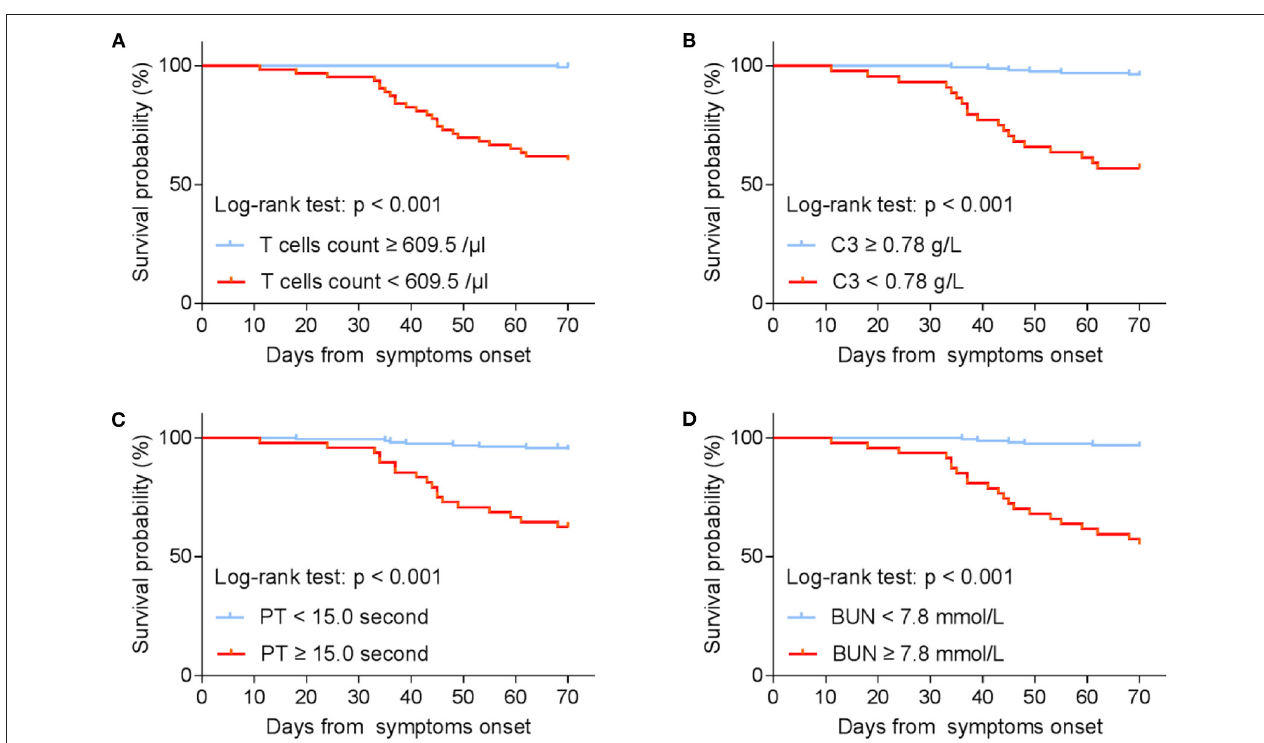
FIGURE 2 | Kaplan–Meier estimates on survival by (A) T cells count; (B) C3; (C) PT; (D) BUN (stratified according to best cut-off). T cell, T lymphocyte; C3, complement component 3; PT, Prothrombin time; BUN, Blood urea